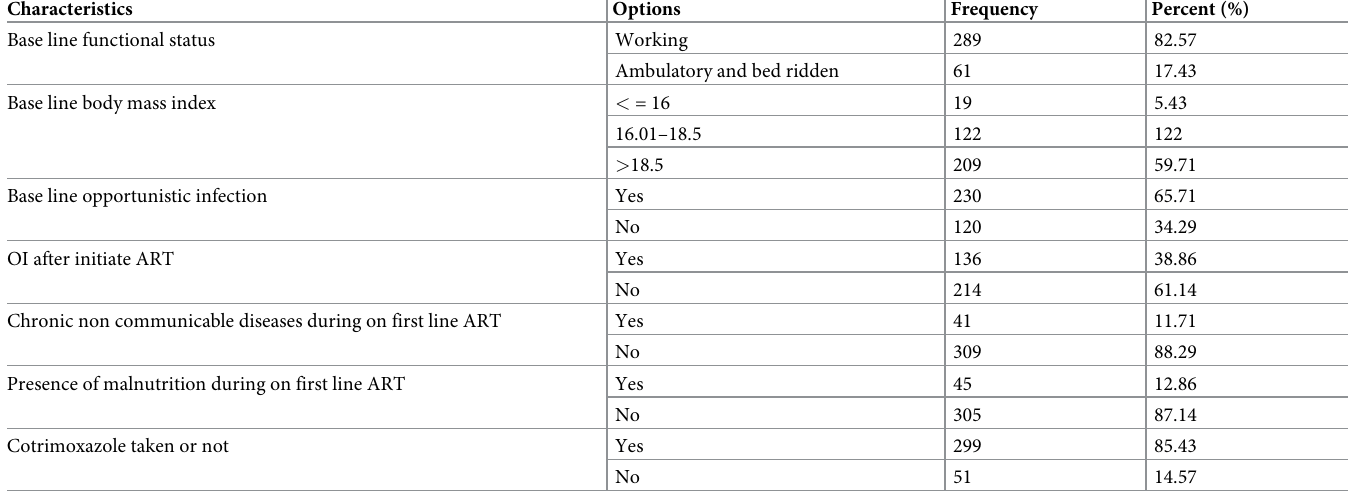
Table 2. Clinical characteristics of patients taking ART drugs at public health facilities in South West Shoa Zone, 2019.